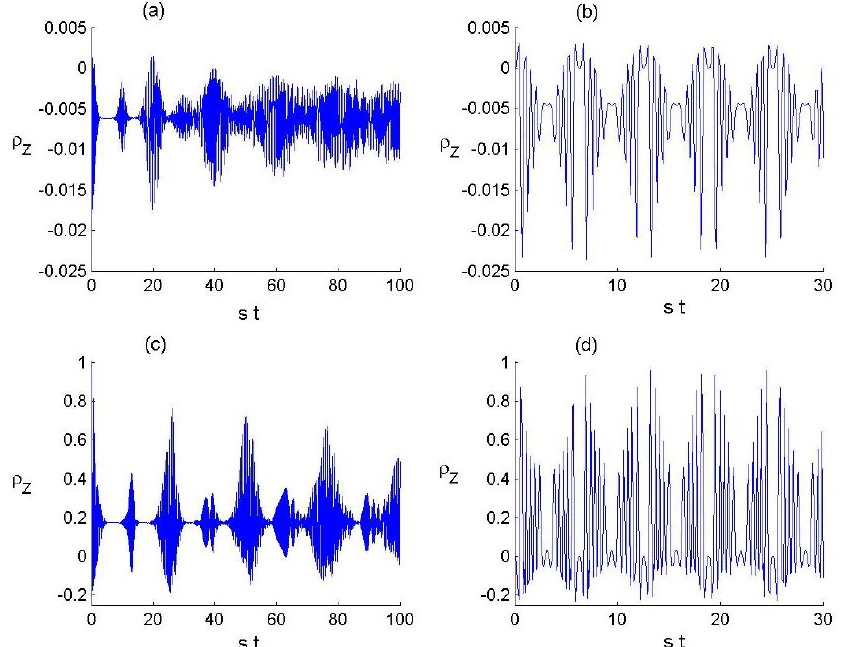
Figure 1. Time variation of the atomic population inversion ρ z for the TQS with θ = π /4 and the radiation field in the PDCSs. Panels ( a , b ) correspond to the case of absence of the PDP effect (i.e., λ = 0 ) for constant ( D ( t ) = s ) and t-dc ( D ( t ) = s sin ( t )) , respectively. Panels ( c , d ) are, respectively, the same as ( a , b ) but in the presence of the PDP effect with 𝜆 = 50 .